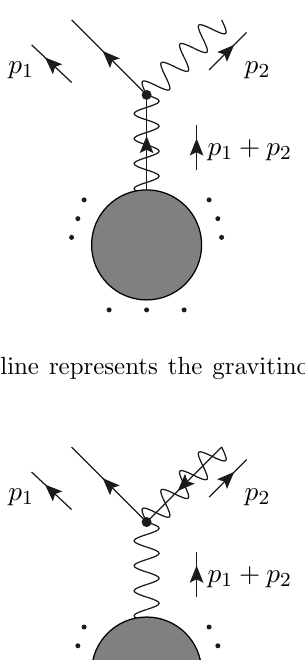
Figure 4 . Virtual graviton decaying into a gaugino pair.